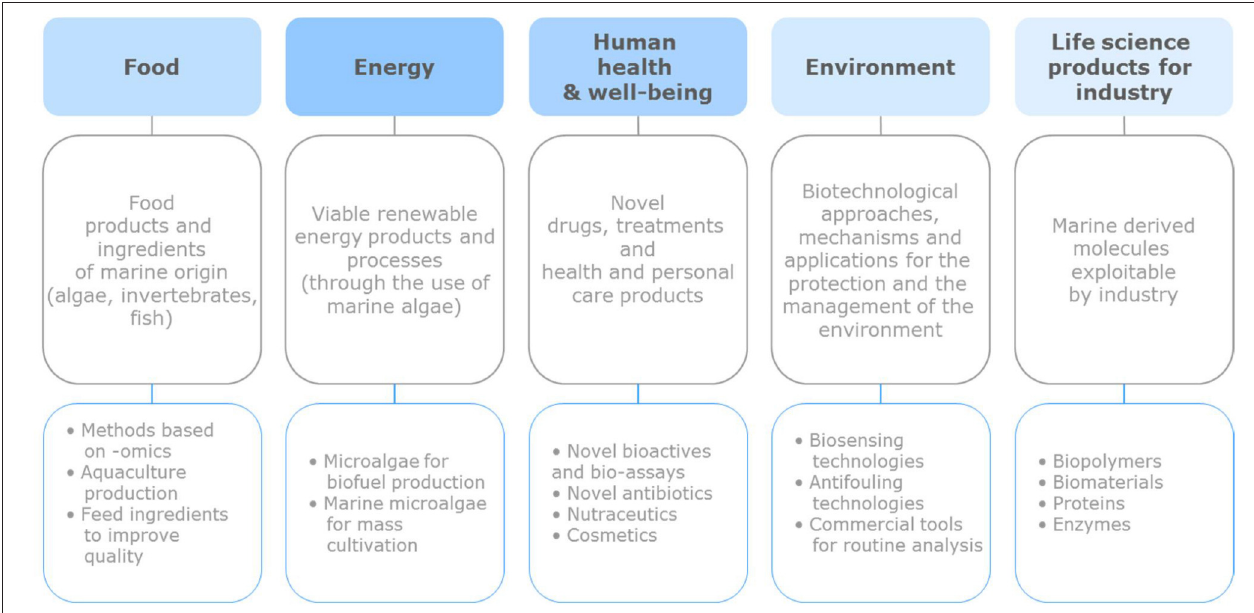
FIGURE 1 | The sectors served by marine